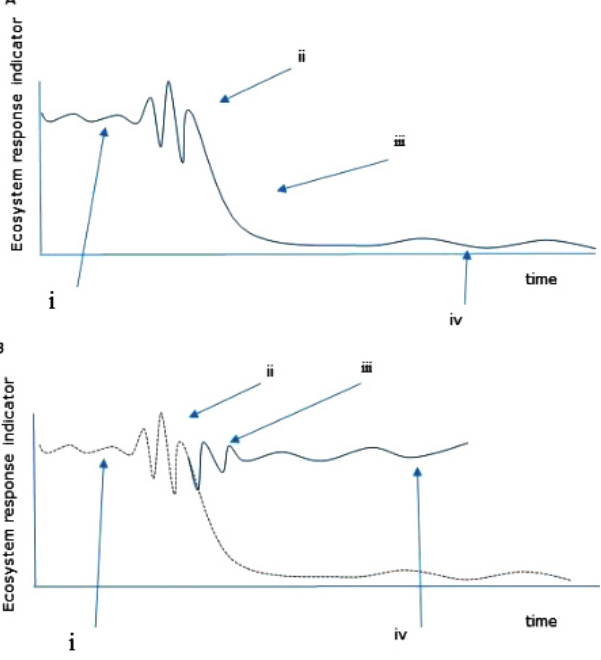
Fig. 1 . The dynamics of surprise for science, governance, and society. Two scenarios are illustrated. Scenario A: (i) Ecosystem appears resilient to stress and the decision is made to push it harder; (ii) increasing variability draws attention to ecosystem change but a wait-and-see approach is taken; (iii) surprise happens and regime shift is detected with hindsight; (iv) a new state is established, recovery is difficult, and ecosystem services change and socioeconomic values and perceived benefits must adapt. Scenario B: (i) Science-governance-society system works to maintain ecosystem resilience; (ii) early warning signs of a possible regime shift are detected from monitoring data; (iii) prompt and effective actions prevent regime shift; (iv) ecosystem services and intrinsic values are retained and socioeconomic values are